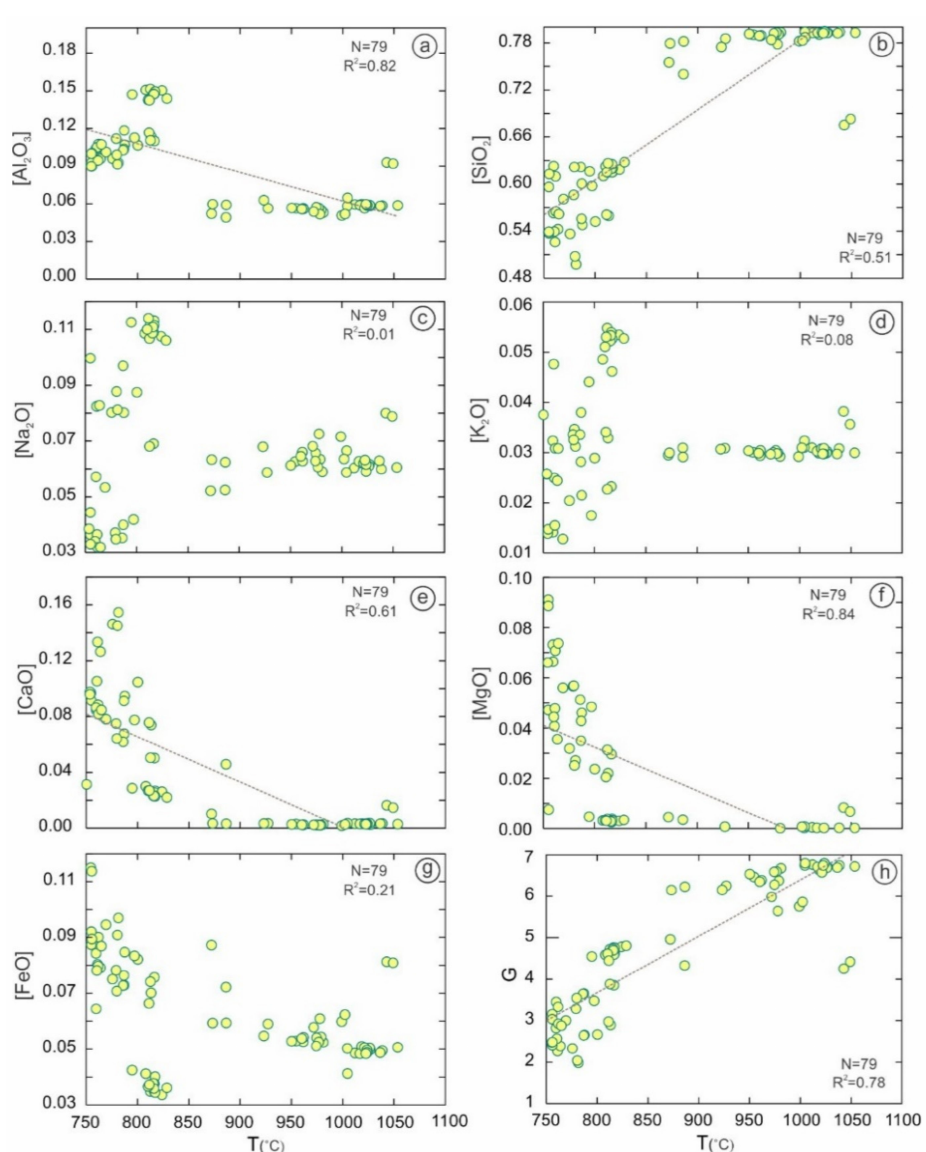
Figure 3. ( a – h ) G variation (3[Al 2 O 3 ] + [SiO 2 ])/([Na 2 O] + [K 2 O] + [CaO] + [MgO] + [FeO]) versus the T Zr (which calculated based on the Equation (S20-2)) in peralkaline to alkaline dataset. G ∝ G16 in experimental data of Gervasoni et al. [20];. Nevertheless, there was a clear relationship among the [Al 2 O 3 ], [SiO 2 ], [CaO], [MgO], and G versus T Zr (n = 79 peralkaline to alkaline rocks with M > 2, and SiO 2 > 45wt.%, http://georoc.mpch-mainz.gwdg.de/georoc/, accessed on 29 August